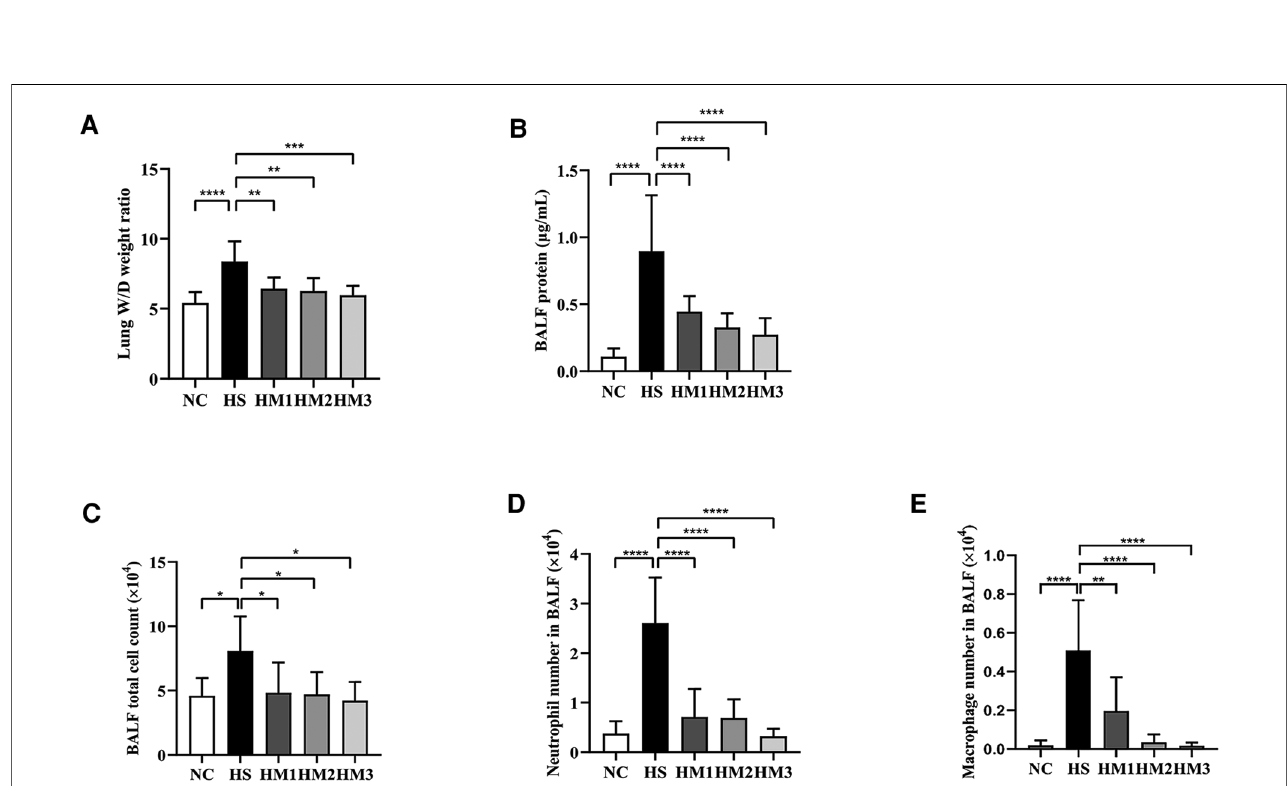
FIGURE 4 Human umbilical cord-derived mesenchymal stem cells (hUC-MSCs) reduces lung edema and lung in fl ammation in hyperoxia-induced bronchopulmonary dysplasia (BPD) of neonatal rats. ( A ) The lung wet/day (W/D) weight ratio, ( B ) Total protein concentration, ( C ) Total cell count, ( D ) Neutrophil number, and ( E ) Macrophage number in bronchoalveolar lavage fl uid (BALF) of rat pups. The rat pups reared in the HS group showed a signi fi cantly increased lung W/D weight ratio, higher BALF total protein concentration, total cell count, and increased neutrophil and macrophage accumulation than did those reared in the NC group. hUC-MSCs (1×10 6 cells, 5×10 6 cells, or 1×10 7 cells) reduced the hyperoxia-induced lung W/D weight ratio, total protein concentration, total cell count, neutrophil number, and macrophage number of BALF increases. * P <0.05, ** P <0.01, and **** P <0.0001. Data was presented as means±SEM, n =6 – 8 per group.